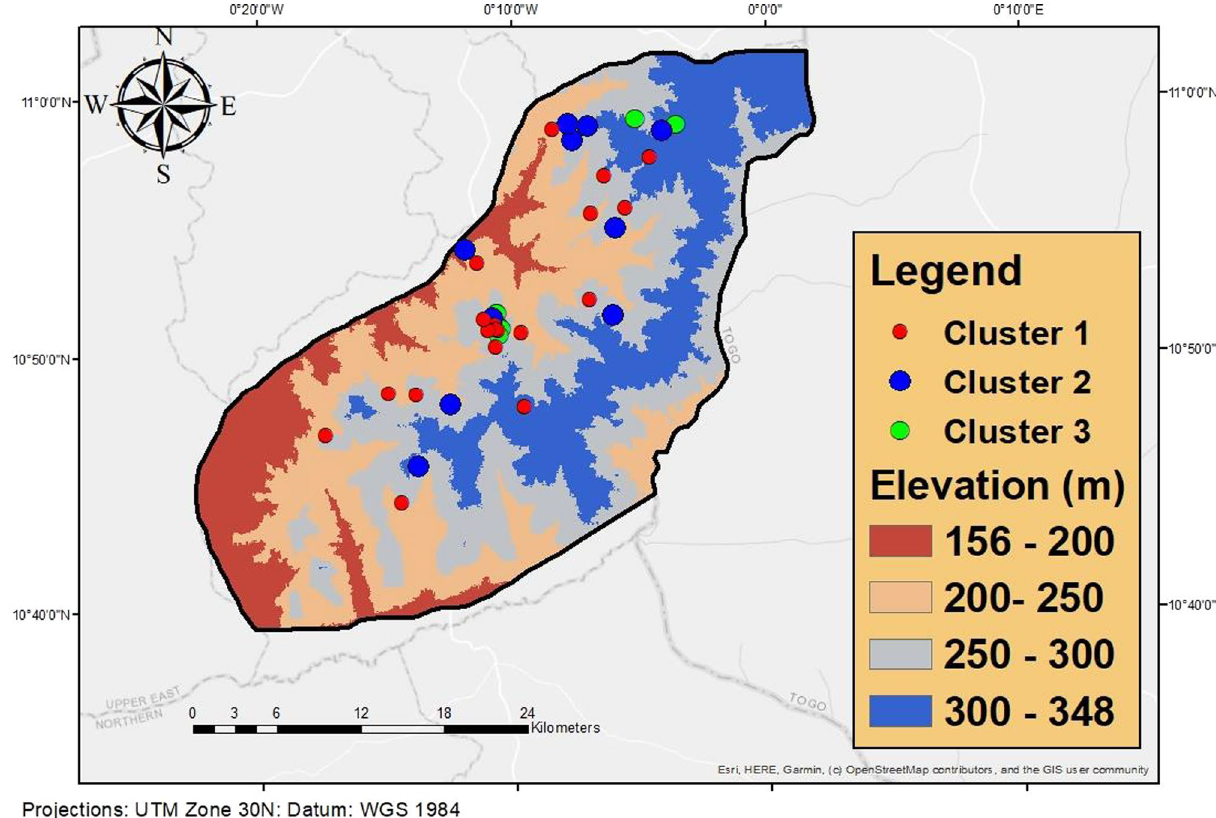
Fig. 7 Spatial distribution of the clusters from the Q-mode HCA